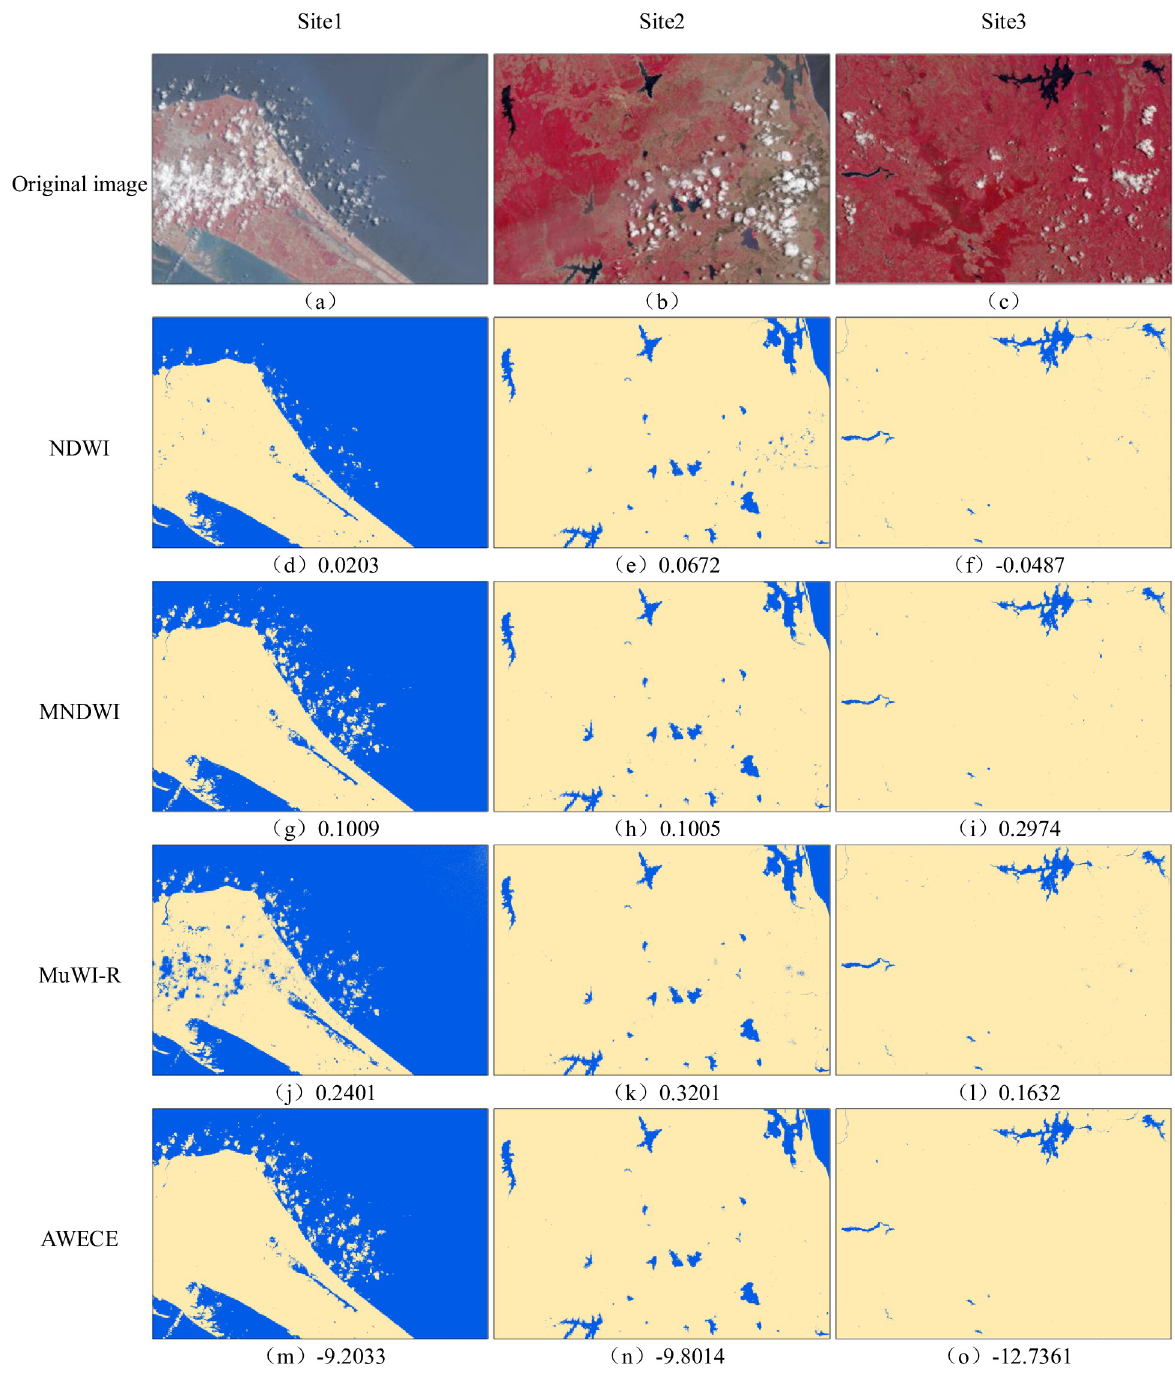
Fig 7. Water extraction results of different models. (a)-(c) are the original images of the three sites. Water extraction results of, (d)-(f) NDWI, (g)-(i) MNDWI, (j)-(l) MuWI-R and, (m)-(o) are the results of water extraction of NDWI, MNDWI, MuWI-R and AWECE respectively. The number after (d)-(o) is represents the threshold determined by the OTSU